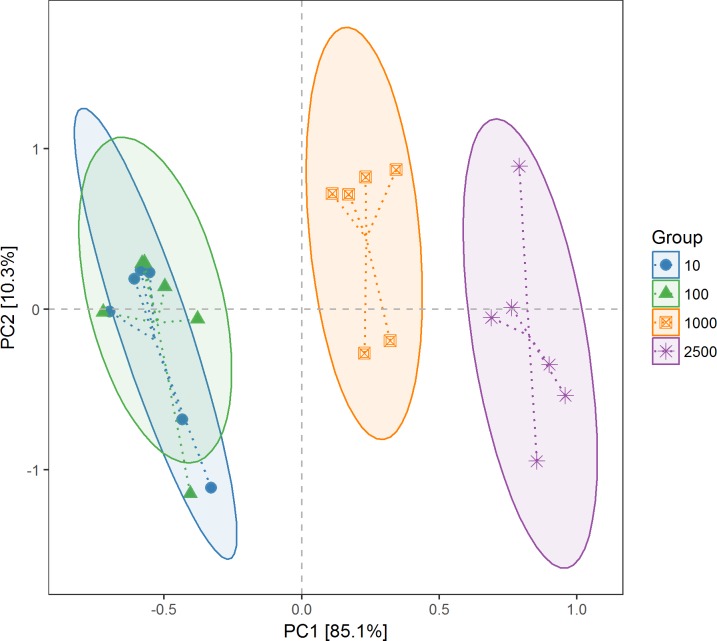
Principal component analysis (PCA) of archaeal operational taxonomic units scores plot generated by a weighted UniFrac analysis at the 97% similarity level from 24 cecal contents of rabbits.There are six replicates in each group.